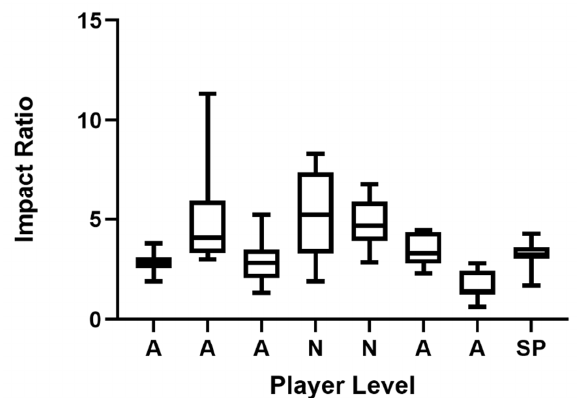
Figure 10. Impact ratio quartile distributions for each participant obtained in field measurements (N is novice, A is amateur and SP is semi-professional).